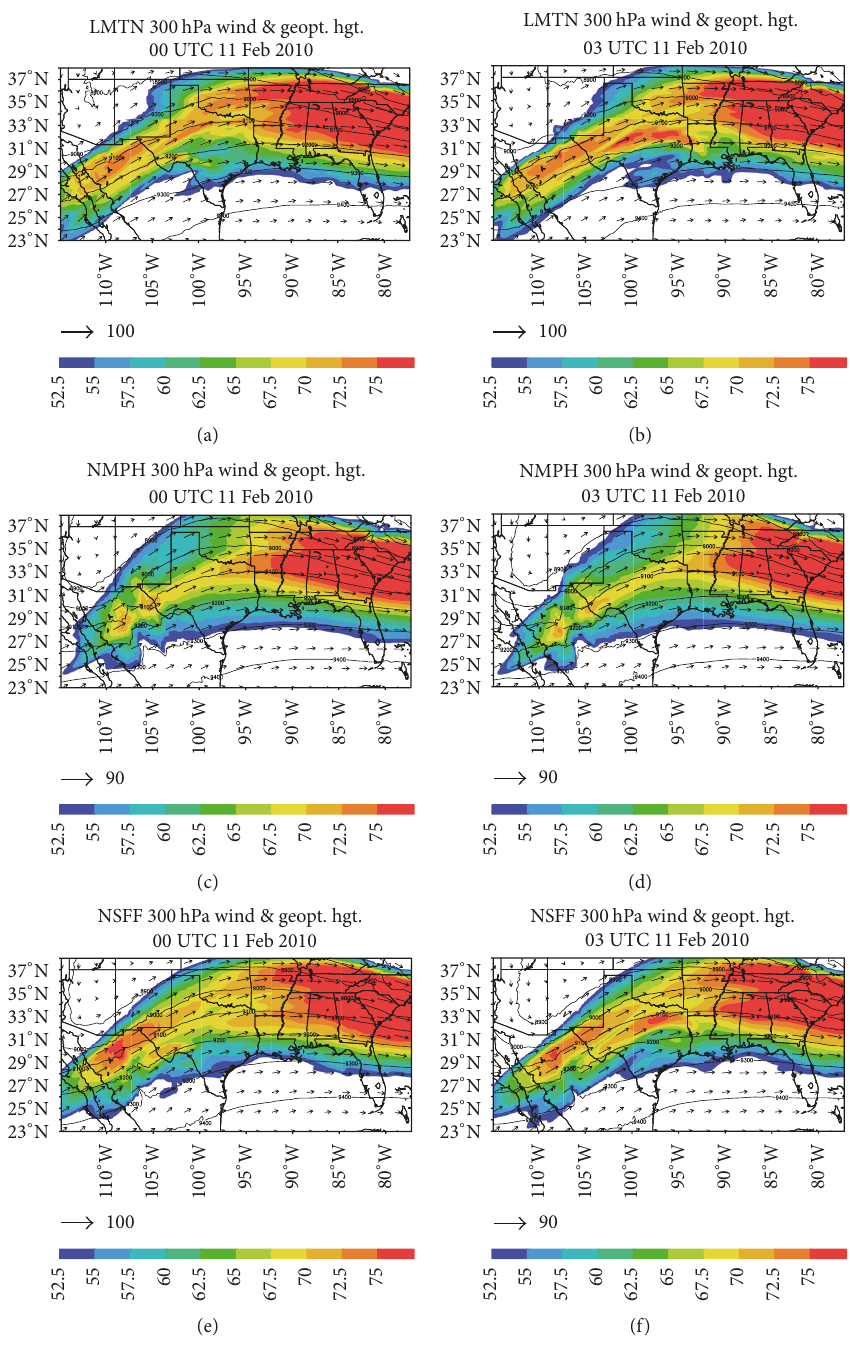
Figure 16: Simulated (12km) 300 hPa wind (m s −1 ) and geopotential height in gpm on 0000 and 0300 UTC 11 February 2010 for (a-b) terrain reduction experiment, (c-d) no microphysics heating experiment, and (e-f) no surface flux experiment.